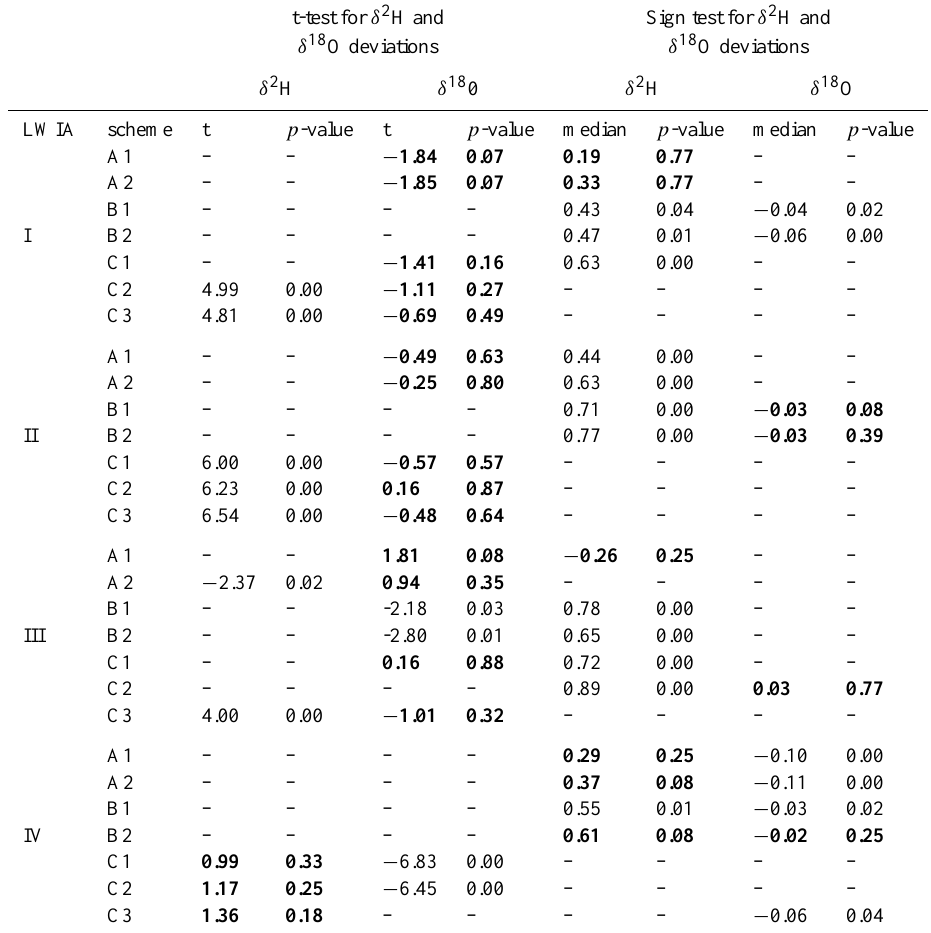
Table 3. Results of one-sample t-test and one-sample sign test for δ 2 H and δ 18 O deviations. The analyses that produced negligible differences between laser spectroscope and mass spectrometer (i.e., not significant difference with α :0.05) are marked in